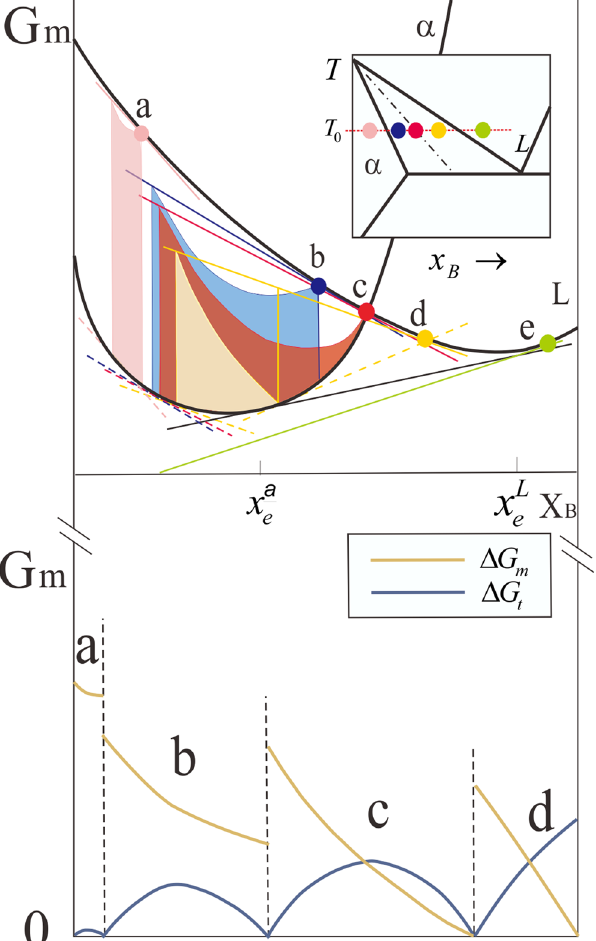
Figure 3. Limits of nucleus composition and distribution of driving force corresponding to different initial alloy